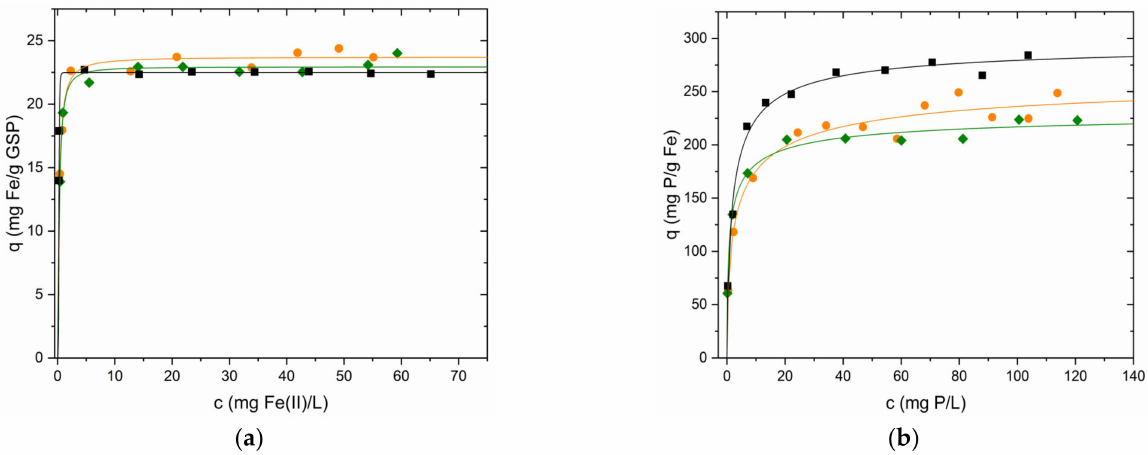
Figure 7. ( a ) Experimental data of Fe sorption on GSP ( • ) S-1, ( (cid:7) ) S-0.5, ( (cid:4) ) S-0.25; solid lines were obtained using the Langmuir–Freundlich model (Equation (S6)). GSP dose 2 g · L − 1 , natural pH, and room temperature. ( b ) Experimental data of phosphorus sorption on GSP-Fe referring to the iron. Solid lines were obtained using Equation (S6). ( • ) GSP-Fe S-1. Dose 2 g · L − 1 , which is equivalent to 47.4 mg Fe · L − 1 . ( (cid:7) ) GSP-Fe S-0.5. Dose 2 g · L − 1 , equivalent to 45.8 mg Fe · L − 1 . ( (cid:4) ) GSP-Fe S- 0.25. Dose 2 g · L − 1 , equivalent to 45 mg Fe · L − 1 . pH 2.1 and room temperature for all